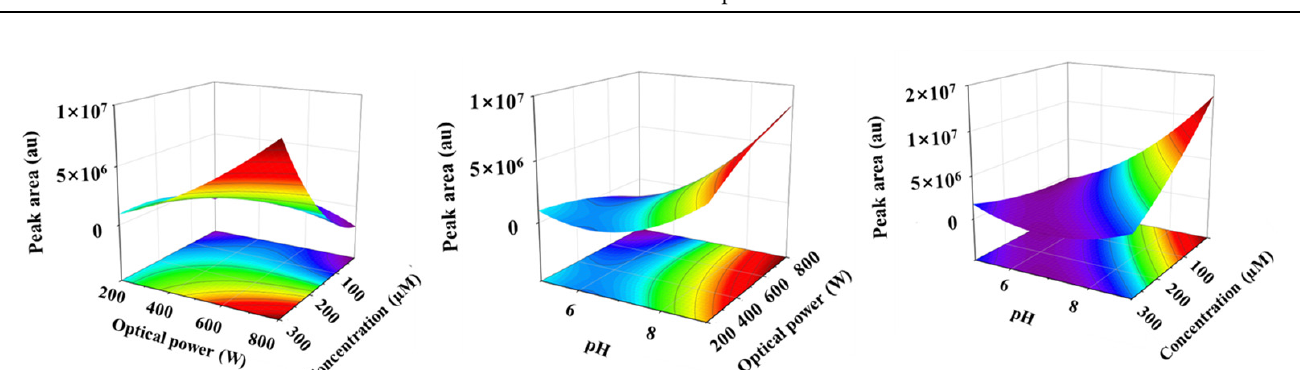
Figure 4. Interactive influence of two factors on the formation of product dimer.